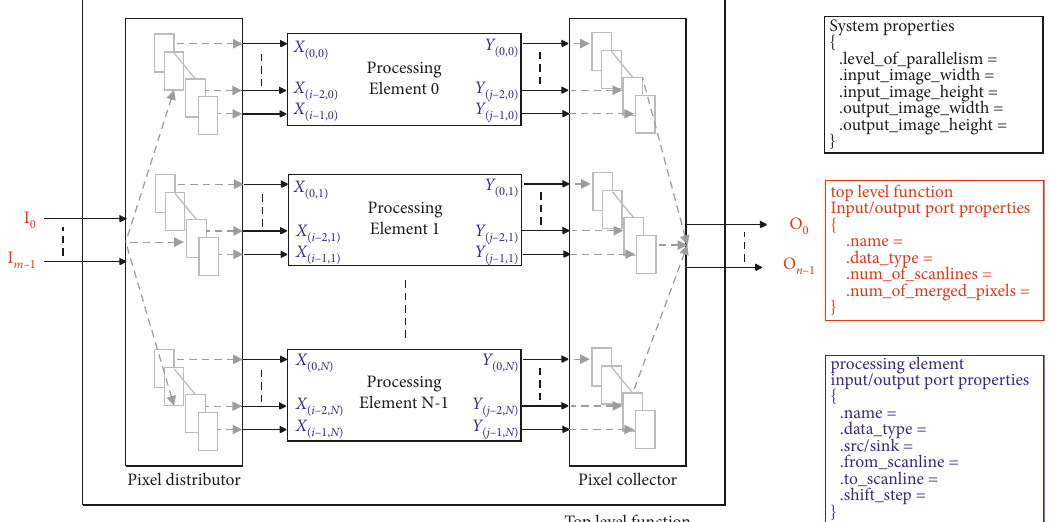
Figure 2: Array-based video processing